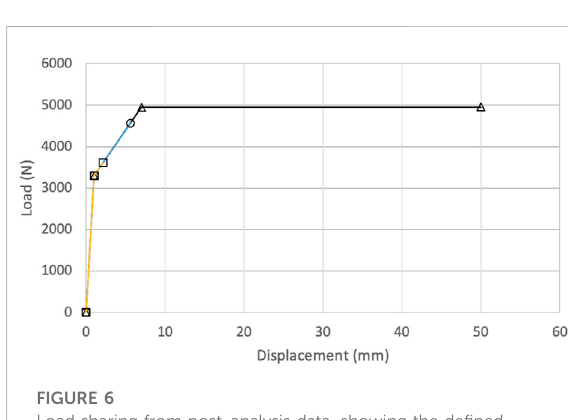
FIGURE 6 Load sharing from post-analysis data, showing the de fi ned load-deformation capacity of the RTWC in the axial direction △ , theloadtaken by theRTWC at thegable end frame ○ , and theload taken by the RTWC at the 11th inner frame □